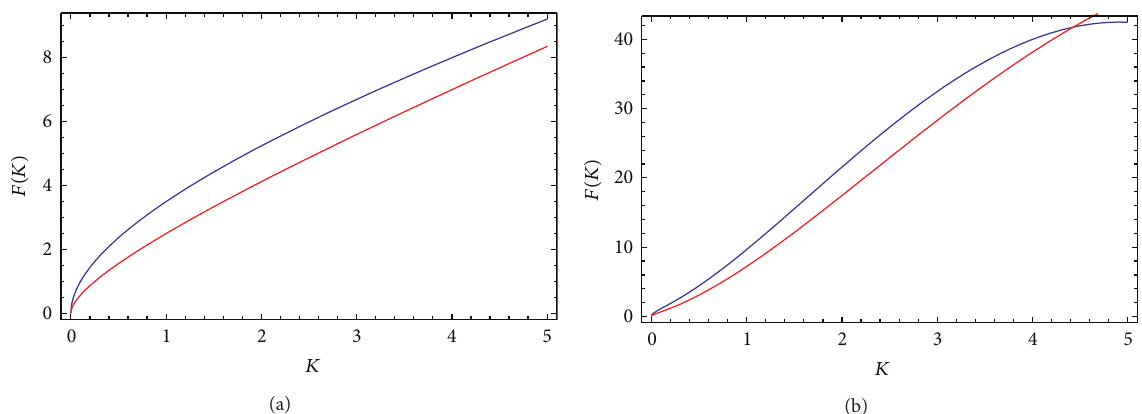
Figure1: ((a)and (b))Thevariationsof 𝐹(𝐾) against 𝐾 for HDEand ECHDEmodels. Bluelinerepresents typeImodel and redlinerepresents type II